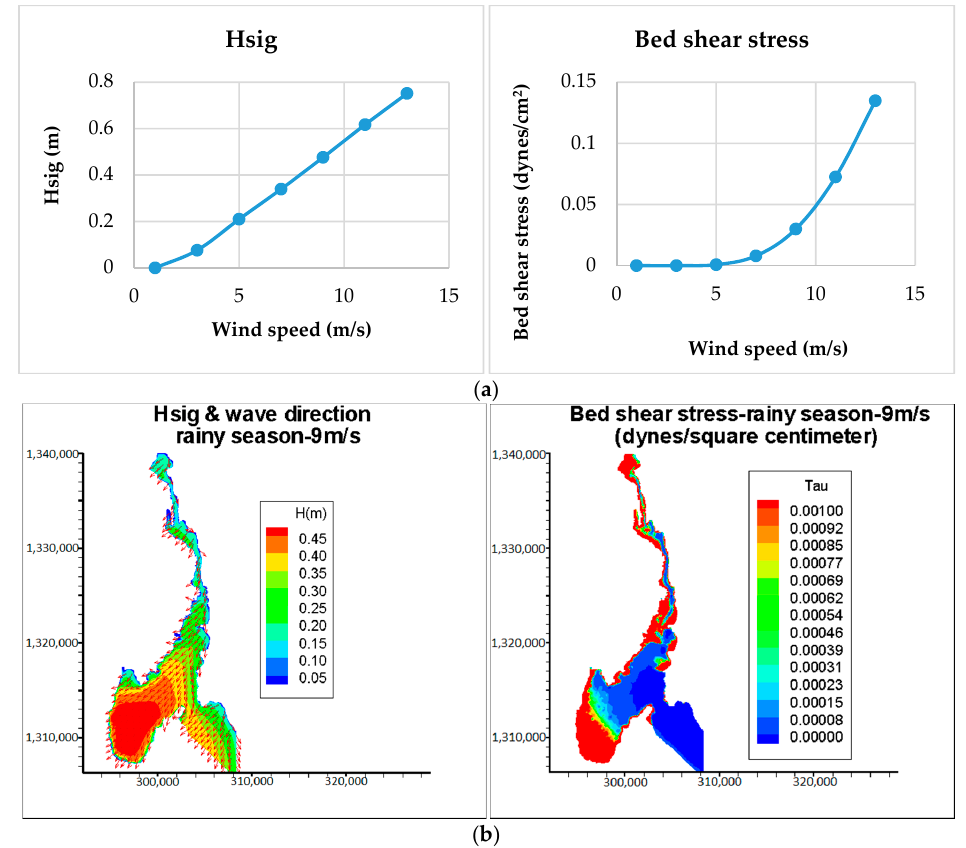
Figure 12. Typical variations of significant wave heights and directions as well as bed shear stresses in rainy season (SW monsoon, − 225 degree). Top panels ( a ) show relationships between wind speeds and significant wave heights and bed shear stresses, respectively, at 296,437.06 lat. 1,308,613.36 long. and bottom panels ( b ) show spatial distributions with the wind speed of 9 m/s.